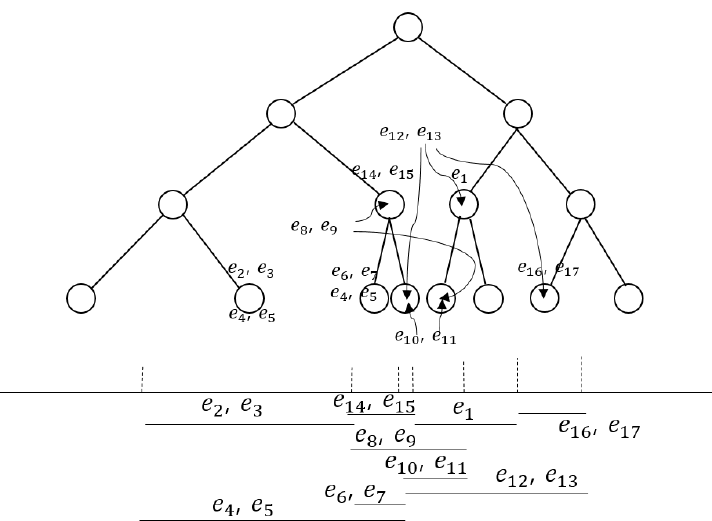
Figure 10. A segment tree storing the boundaries of sensing